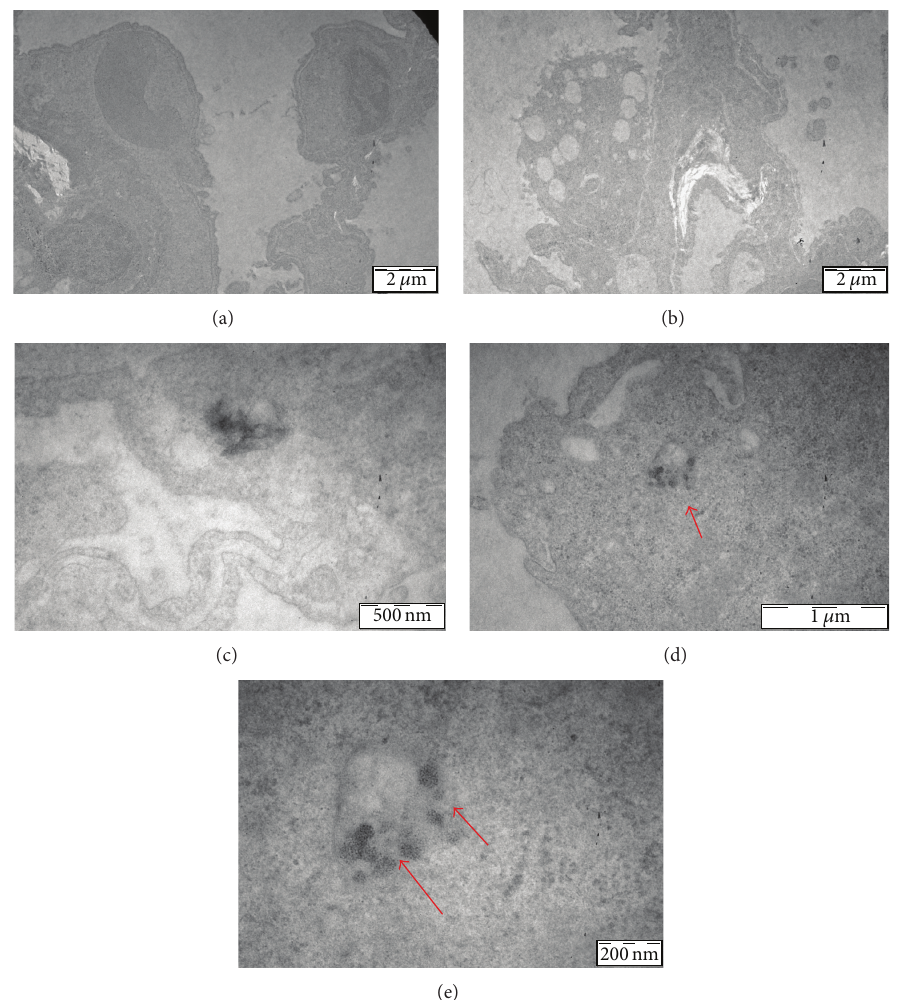
Figure 2: Electron micrographs of ultrathin lung sections of negative control ((a) 7900x, (c) 46000x) and treated mice ((b) 7900x, (d) 34000x, (e) 92000x). In lung sections from treated animals small nanoparticle aggregates, uptaken by the alveolar macrophages (arrows), can be